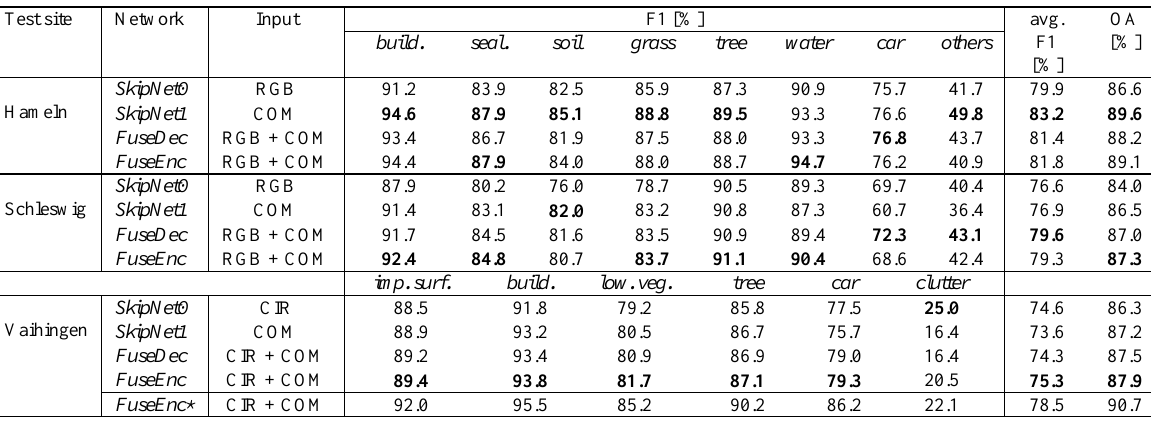
Table 1 . Results of land cover classification of all networks. COM: composite images, F1: F1 score, OA: Overall Accuracy, both evaluated on the basis of pixels. Best scores are printed in bold font. In Vaihingen, FuseEnc* is evaluated on the eroded reference , other variants are evaluated on the full reference